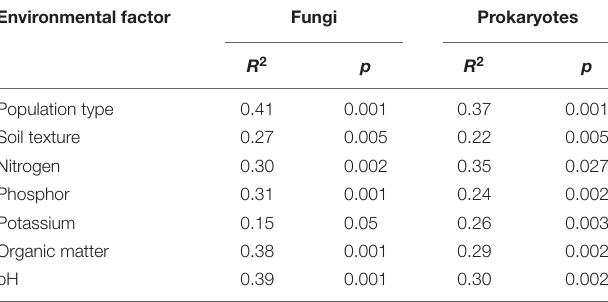
TABLE 1 | Significance of the evaluated environmental parameters on the structure of the soil microbiota, assessed by ADONIS test, with 999 permutations. Environmental factor